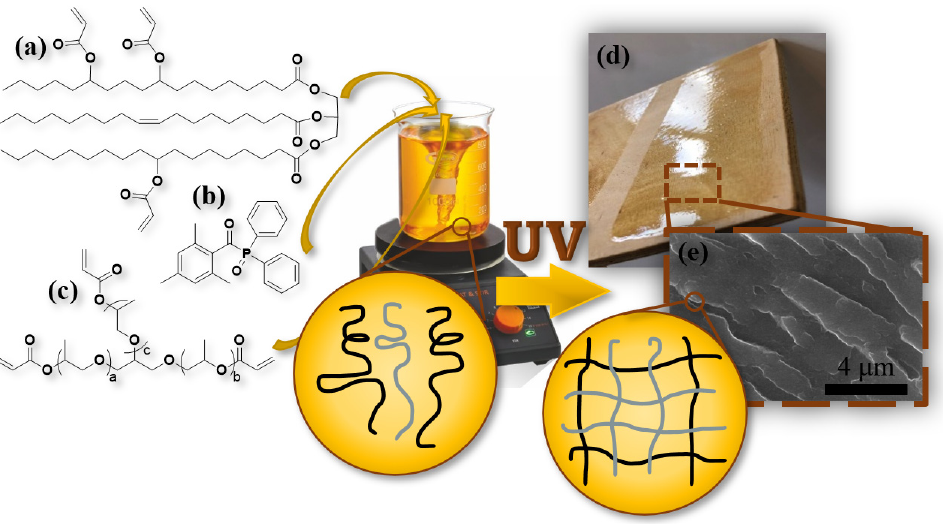
Figure 1. Scheme for this study: ( a ) acrylated vegetable oil (generalized structure); ( b ) TPO photoinitiator; ( c ) GPT monomer; ( d ) ultraviolet (UV)-cured acrylated vegetable oil coating on plywood; ( e ) formation of microstructure, SEM image.